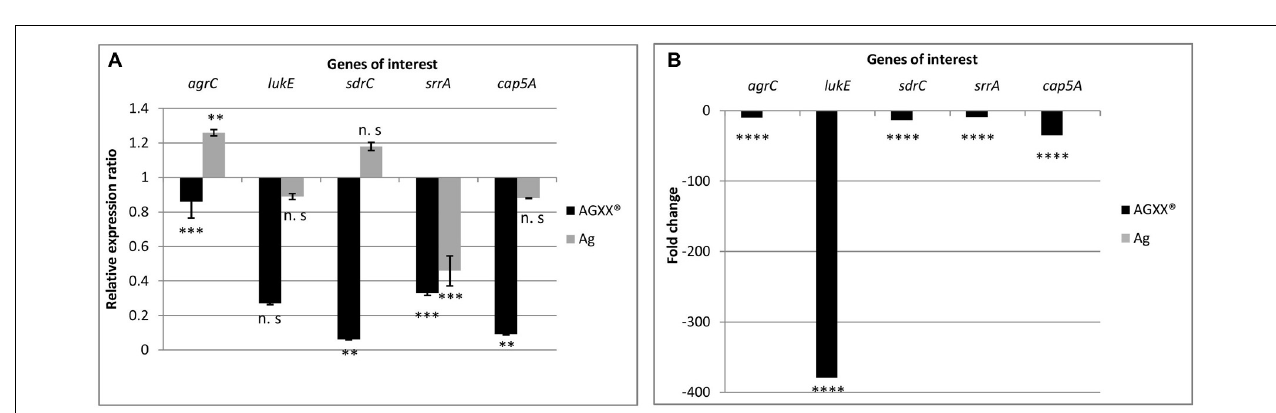
FIGURE 6 | Differential expression of agrC , lukE , sdrC , srrA , and cap5A in S. aureus 04-02981 on 24-min exposure to Ag or AGXX R (cid:13) , obtained via RT-qPCR (A) . Expression ratio of the genes of interest in S. aureus 04-02981 on exposure relative to control (untreated culture of S. aureus 04-02981) normalized to gyrB . (B) Shows differential expression of agrC , lukE , sdrC , srrA , and cap5A in S. aureus 04-02981 on 24-min exposure to Ag or AGXX R (cid:13) , obtained via RNA-seq as fold change. Error bars indicate standard deviation. Asterisks indicate p -values showing statistical significance. They were obtained from t -test using SigmaPlot 11.0 ( ∗∗∗∗ p < 0.0001, ∗∗∗ p < 0.001, ∗∗ p < 0.01, ∗ p < 0.05; n.s, not